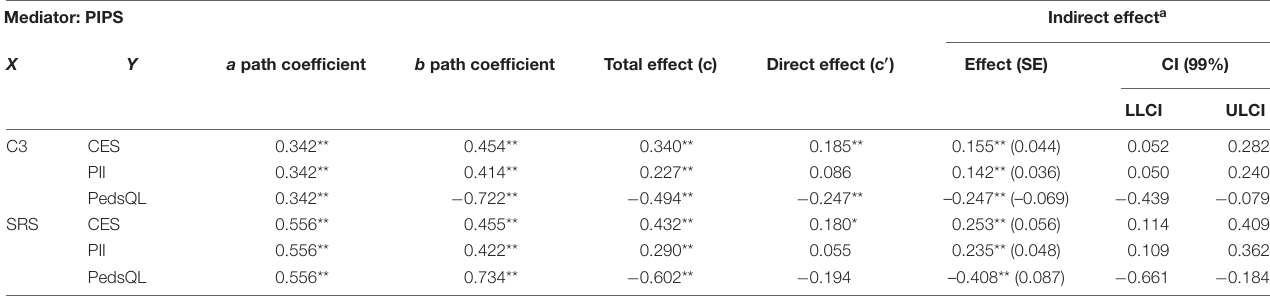
TABLE 5 | Total, direct and indirect effects of autistic traits (SRS) and ADHD symptoms (C3) on depression (CES-DC), pain interference (PII), and HRQoL (PedsQL), using psychological inflexibility (PIPS) as mediator with adjustment for age, gender, and level of pain intensity (LPQ) ( n = 146). Mediator: